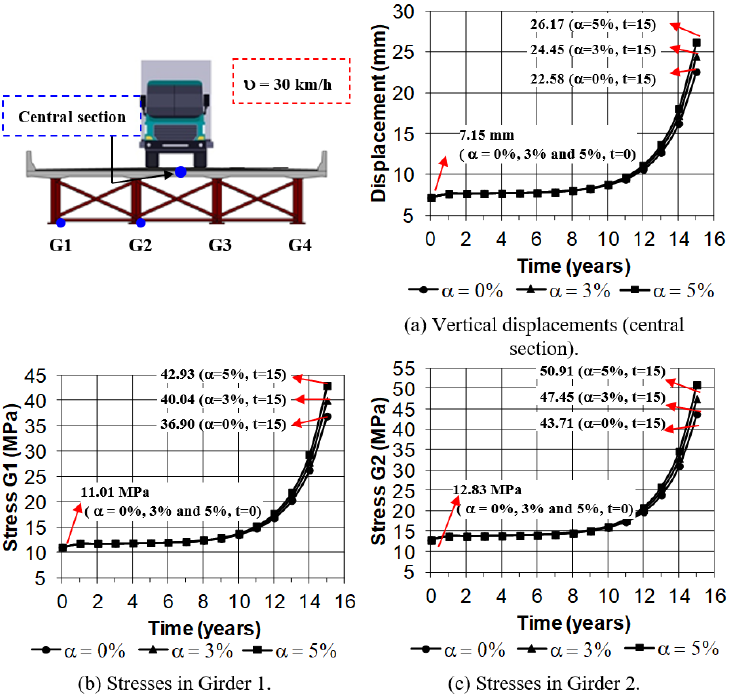
Figure 12. Pavement progressive deterioration effect: υ = 30 km/h (traffic central